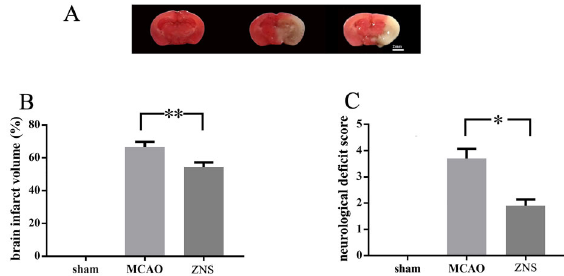
Figure 3. Effect of zonisamide (ZNS) on neurological de fi cit and infarct size in middle cerebral artery occlusion (MCAO) mice. A , Representative images of brain sections (from left to right: sham, MCAO, and ZNS; scale bar: 2 mm) and ( B ) statistical results. C , Mice with ZNS treatment showed lower neurological de fi cit scores. ZNS: middle cerebral artery occlusion surgery + ZNS treatment; sham: sham surgery. The data are reported as means ± SE (*P o 0.05, **P o 0.01 one-way